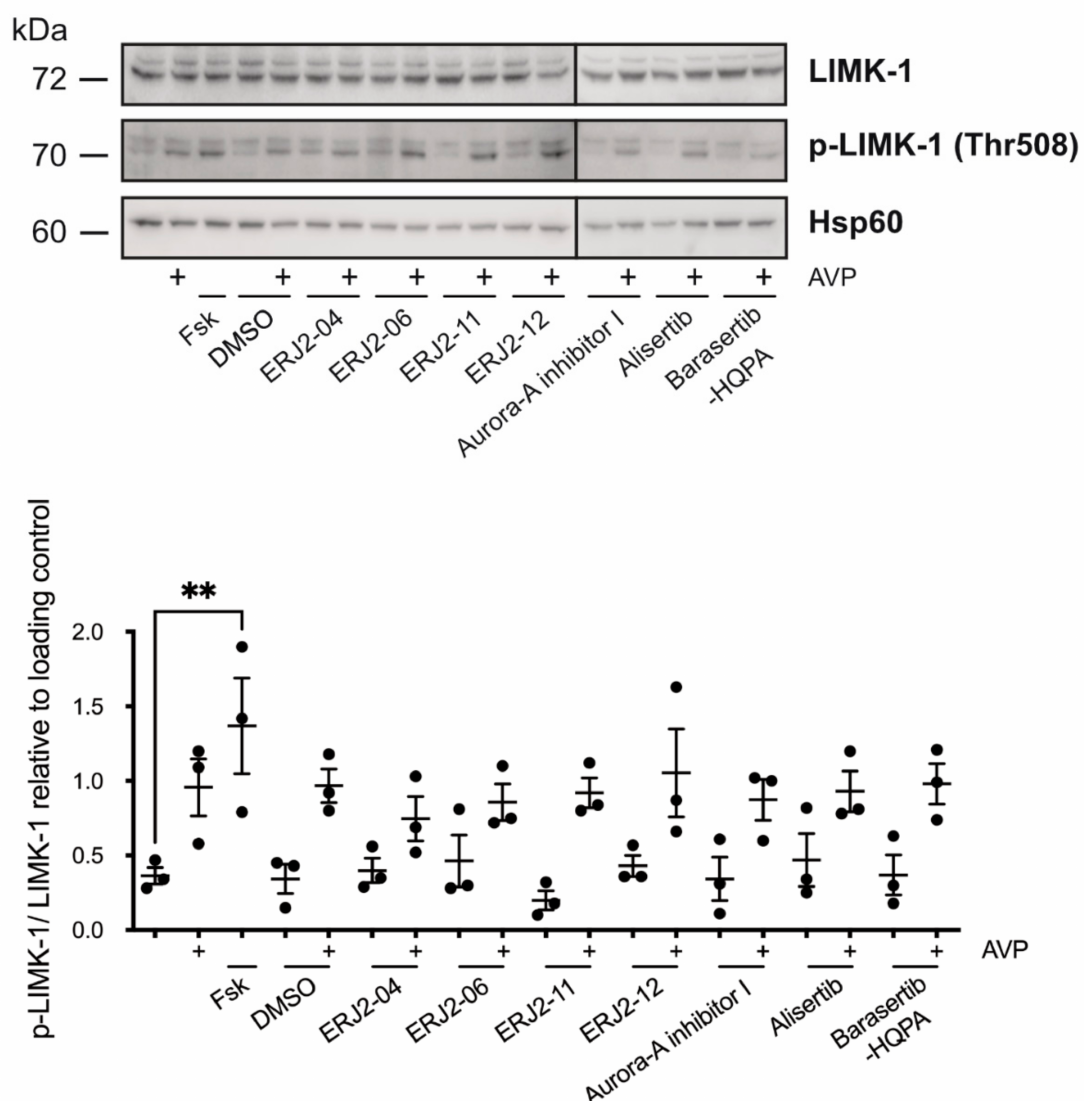
Figure 12. AURKA and AURKB inhibitors do not affect the phosphorylation of LIM kinase-1 (LIMK-1) in primary IMCD cells. Cells were left untreated or treated with forskolin (Fsk; 30 µ M, 30 min), DMSO (0.2%, 1 h), or compound (20 µ M, 1 h) alone or in combination with arginine-vasopressin (AVP; 100 nM, 30 min). Cell lysates were prepared and LIMK-1, phosphorylated (p-)LIMK-1 (threonine (Thr) 508), and Hsp60 as loading control were detected by Western blotting using specific antibodies. The signals were semi-quantitatively analyzed by densitometry and normalized to the loading controls. Shown are representative blots and means ± SEM of three independent experiments. Statistically significant differences are indicated, ** p <